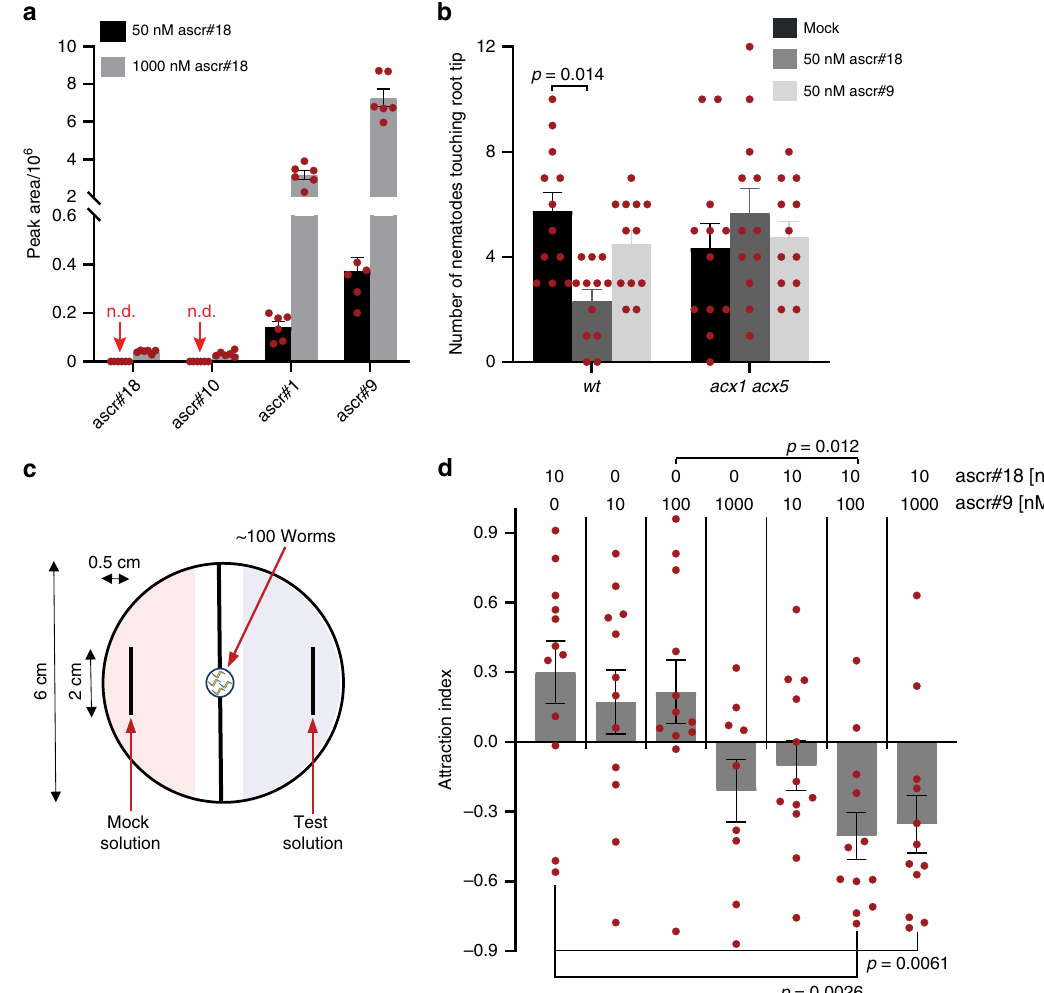
Fig. 5 Plant-derived ascaroside blends deter root-knot nematodes. a Relative abundances of ascarosides in root exudates of Arabidopsis treated with 50 and 1000 nM ascr#18, as determined LC-MS. Data are average ± SEM ( n = 6), n.d. = not detected. b Arabidopsis wildtype and acx1 acx5 were treated with 50 nM ascr#18 or ascr#9 for 48 h before transfer into 12-well plates containing Pluronic F-127 gel with ~200 freshly hatched M. incognita J2 larvae. Larvae touching the terminal part of roots were counted at 6 h after seedling transfer. Data are average ± s.d. ( n = 12). c A small volume (10 µ L) of ascr#18, ascr#9, or ascr#18/ascr#9 solutions was placed on one side of a 6-cm Petri dish with mock solutions on the other side. Subsequently, ~100 freshly hatched M. incognita J2 larvae were placed in the center of the plate. Larvae in the indicated scoring areas were counted after 4 h. d Attraction index for different concentrations of ascr#18, ascr#9, or ascr#18/ascr#9 mixtures measured using the layout shown in c . Data are mean ± SEM ( n = 12). Adjusted p -values in Fig. 5b were calculated by two-way ANOVA followed by Tukey multiple comparisons post hoc test. For Fig. 5d, adjusted p -values were calculated by one- way ANOVA followed by Tukey multiple comparisons post hoc test. Source data are provided as a data fi